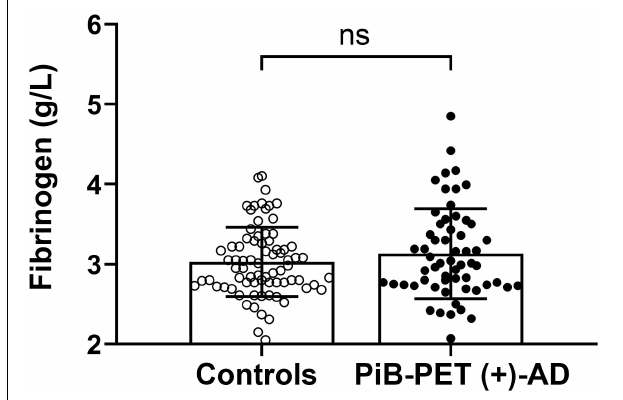
FIGURE 1 | Comparison of the plasma fibrinogen levels between the controls and PiB-PET (+)-AD patients. ns denotes no statistical